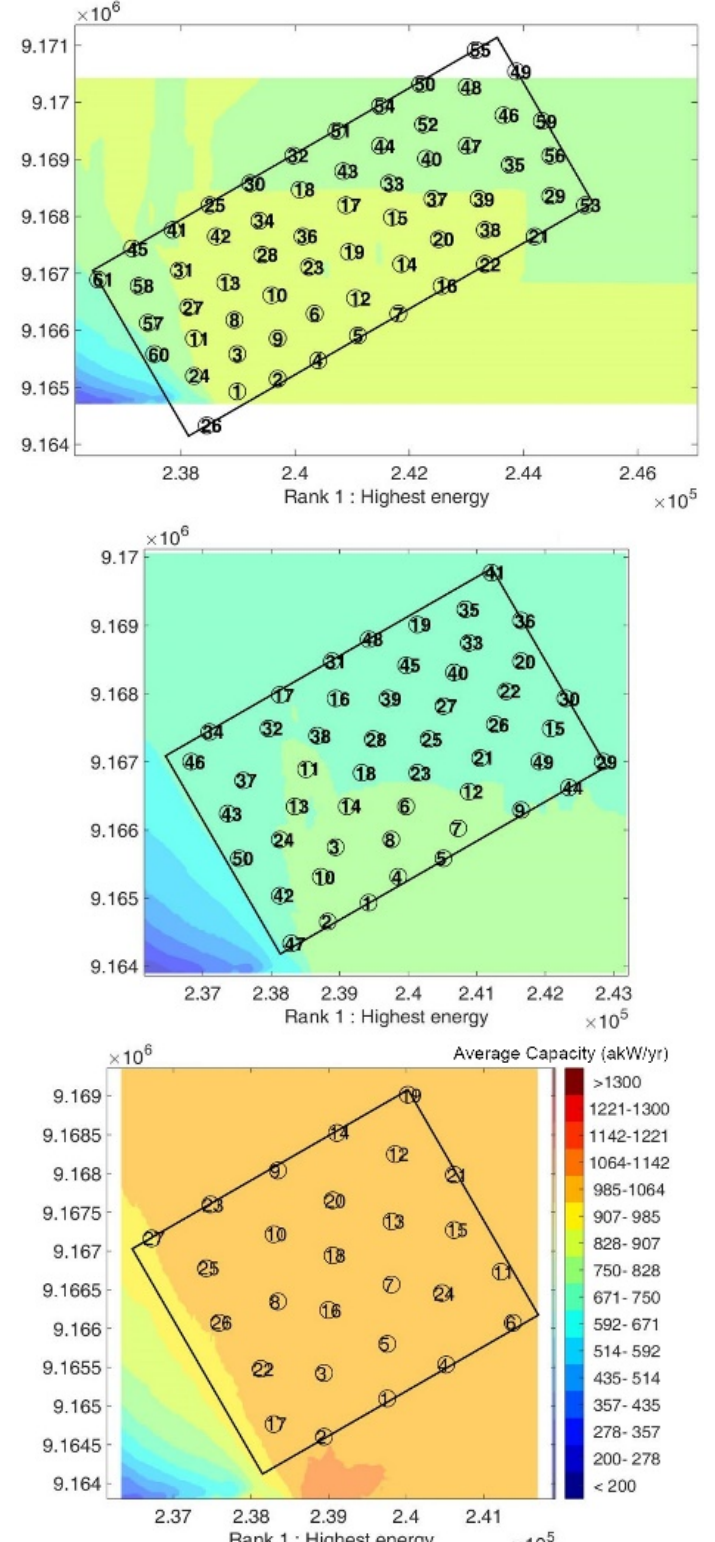
Figure 11. Energy maps and optimized wind farm layouts off Wetar Island using turbine A ( top ), turbine B ( middle ), and turbine C ( bottom ) in Area-1, Area-2, and Area-3, respectively. The wind farm layout was optimized using the module Park Optimizer of WindSim.